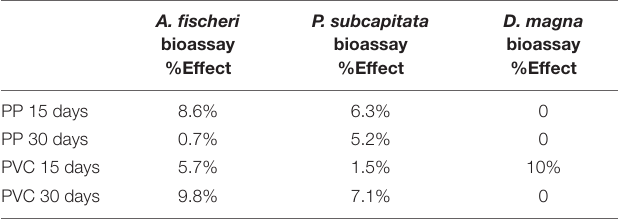
TABLE 2 | Ecotoxicological effect of post-treatment samples obtained with A. fischeri , P. subcapitata , and D. magna bioassay in terms of effect percentage.